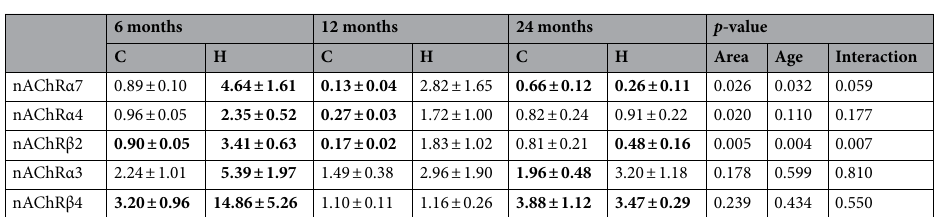
Table 3. Gene expression levels (2 –ΔΔCt ) of nAChRs, in different brain regions and at different postnatal ages, in Tg mice respect to age-matched WT. Data are reported as mean ± SEM. p-values derived from a linear mixed model with brain region as the within variable and age as the between variable. Statistically significant comparisons with respect to similarly aged WT mice are shown in bold characters (p < 0.05). C cortex, H